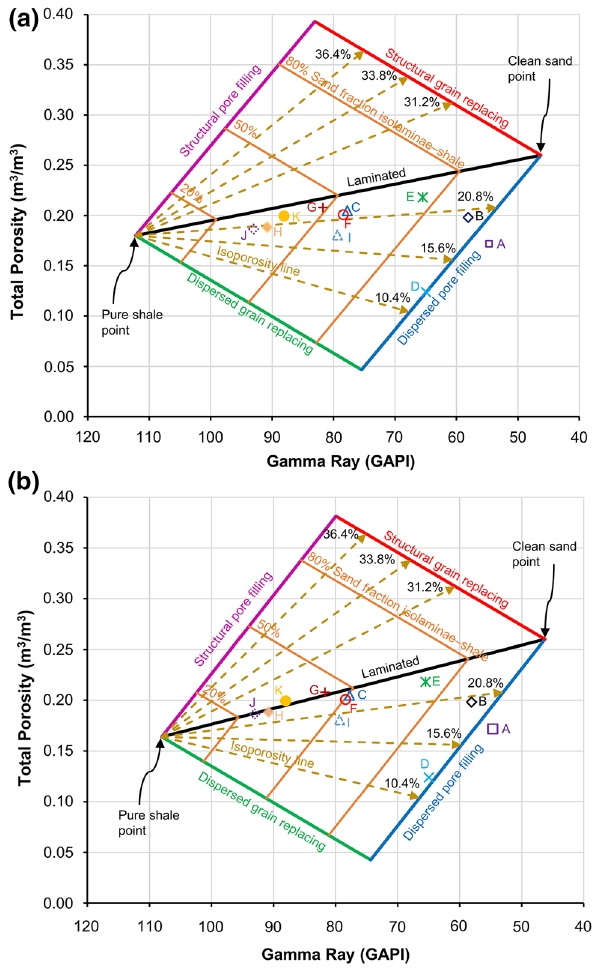
Fig. 7 Thomas–Stieber cross-plot of gamma ray and total poros- ity using zones mean property. a clean sand point is (46.274, 0.26), and pure shale point is (112.243, 0.180) where the pure shale poros- ity was increased by 10% from the base case. b clean sand point is (46.274, 0.26), and pure shale point is (108.013, 0.164) where the pure shale gamma ray was decreased by 4% from the base